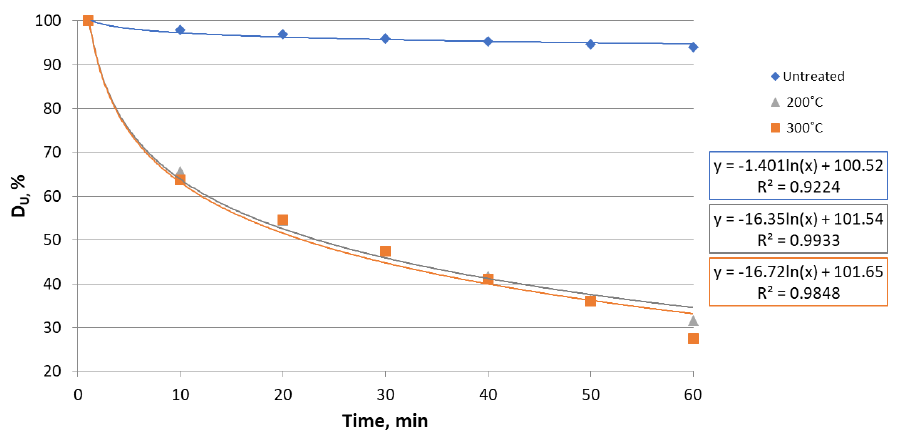
Figure 6. Mechanical durability of untreated and torrefied beetroot pomace pellets.